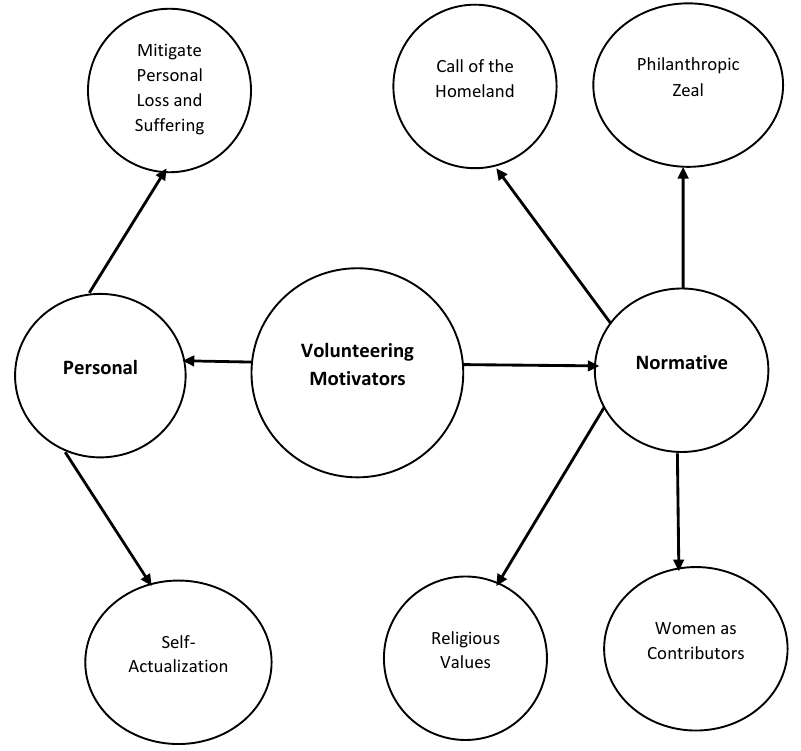
Figure 1. Normative and personal motivators of volunteering.